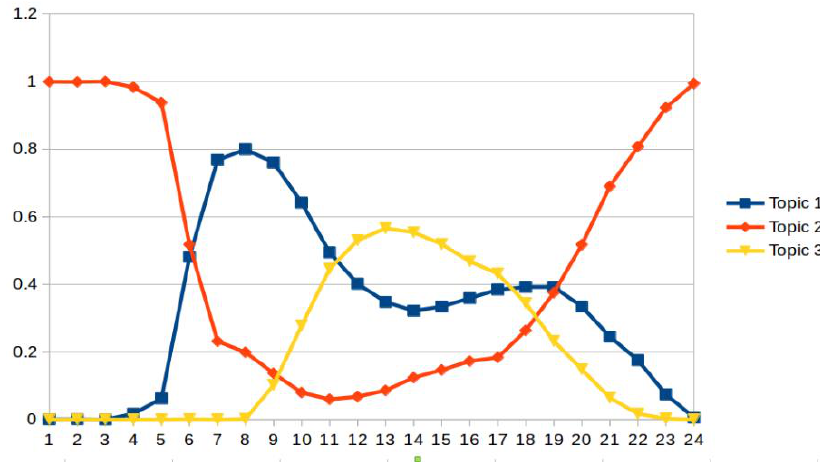
Figure 3. Time patterns of three principal topics extracted from CDRs.